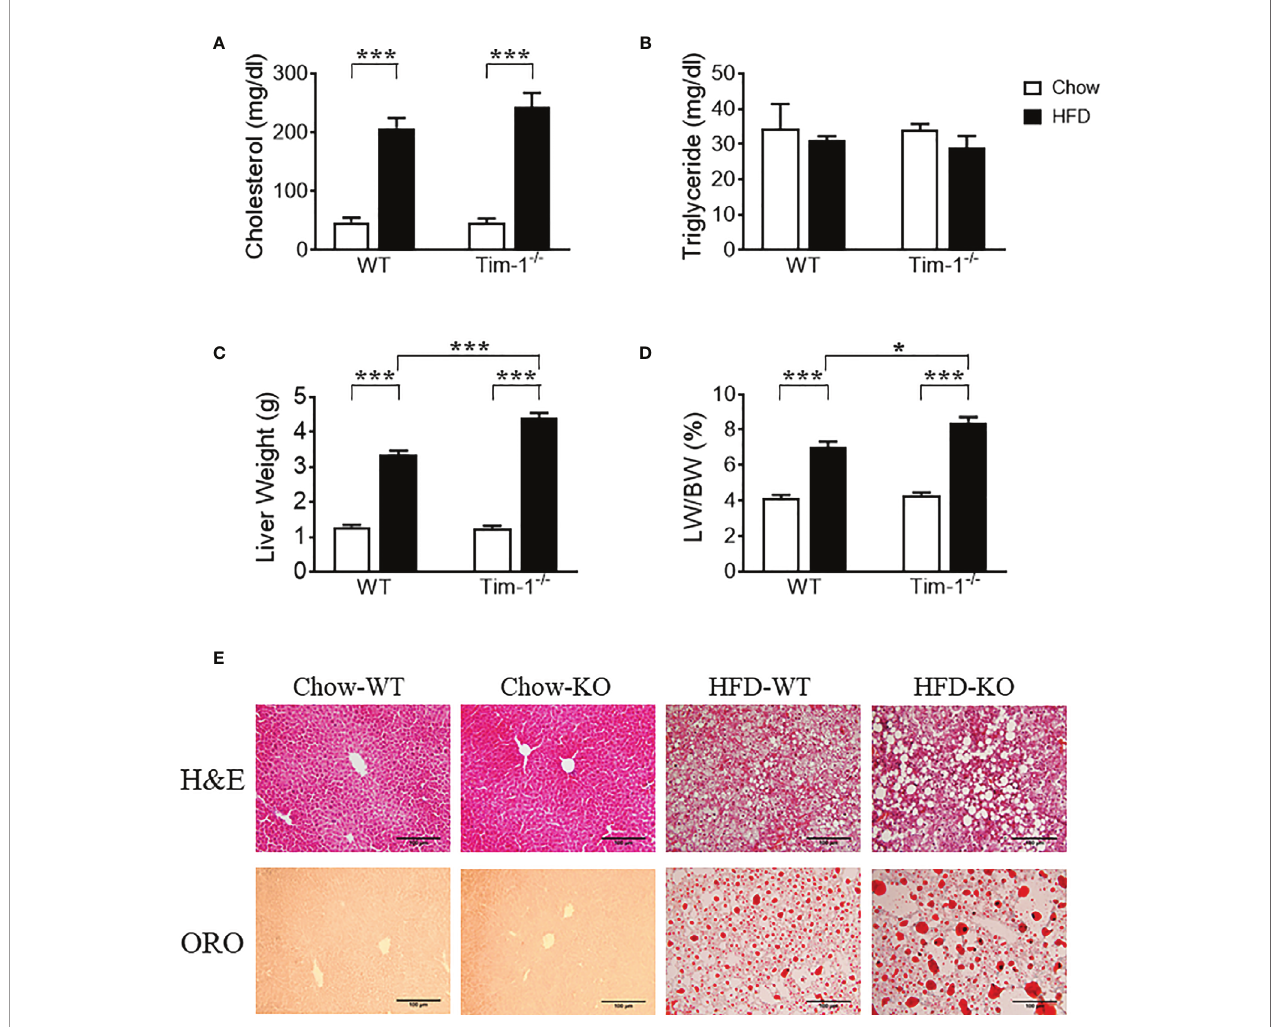
FIGURE 3 | Tim-1 de fi ciency accelerated diet-induced hepatic steatosis. Serum levels of cholesterol (A) and triglyceride (B) , liver weight (C) , and liver weight to body weight (LW/BW) ratio (D) in chow or high-fat diet (HFD) WT and Tim-1-di fi cient (Tim-1 -/- ) mice. (E) Representative images of H&E and Oil red O (ORO) staining of WT and Tim-1-de fi cient (KO) livers (scale bar = 100 µm). Values are mean ± SEM. n=4-6 mice. Statistical differences were assessed by one-way ANOVA with Tukey ’ s multiple comparisons test; * P <0.05, *** P